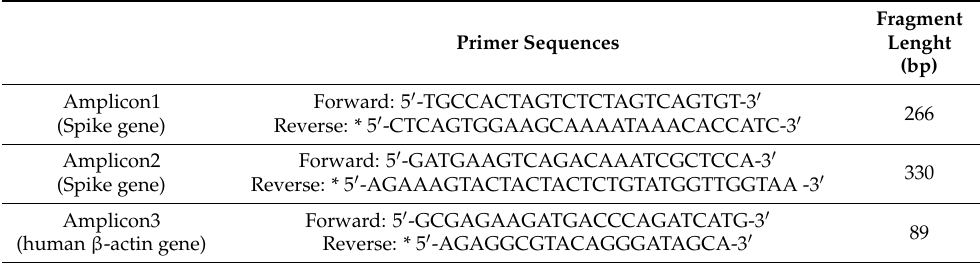
Table 1. Primers sequences for SARS-CoV-2 and human β -actin gene amplification. Primer Sequences